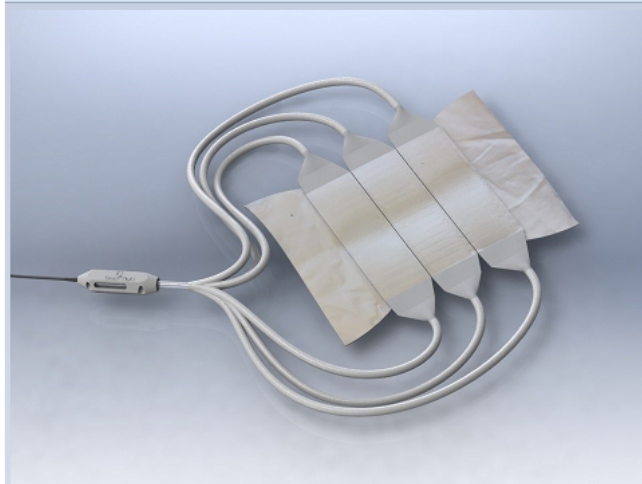
Figure 2. PAGETEX light emitting